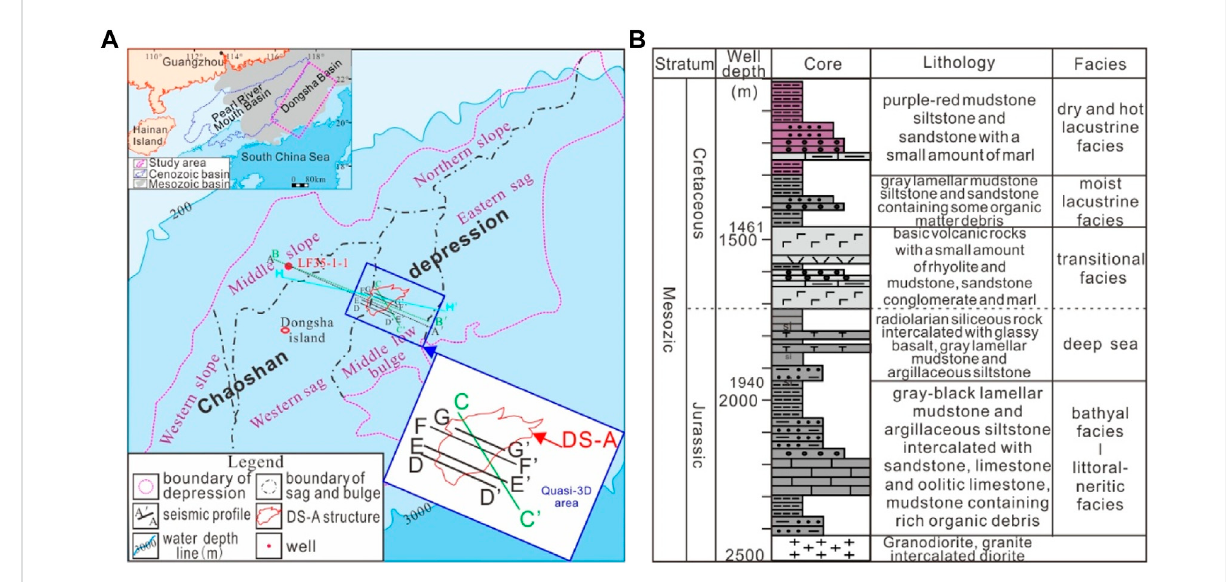
FIGURE 1 Locationmapandstratigraphiccolumnmap. (A) Locationmapofthestudyareaandsurveyline,structuralzoningmapofChaoshanDepression; (B) stratigraphic column of well